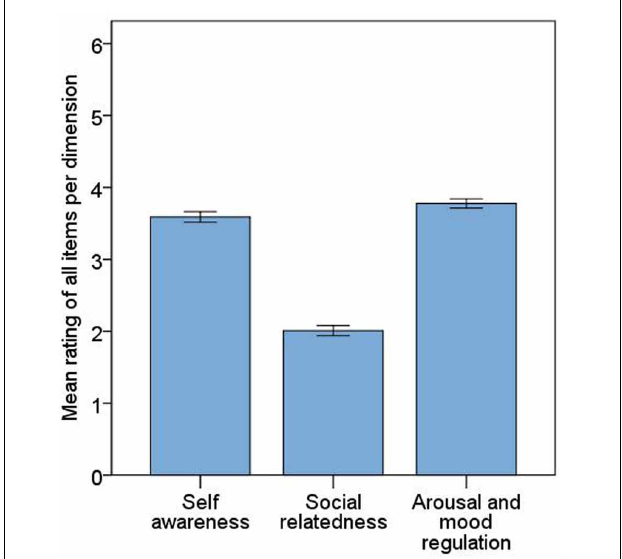
FIGURE 1 | The three distinct dimensions emerging from 129 reasons for listening to music. Error bars are 95% confidence intervals. Self-awareness: M = 3 . 59 ( SE = 0 . 037); social relatedness: M = 2 . 01 ( SE = 0 . 035); arousal and mood regulation: M = 3 . 78 ( SE = 0 .